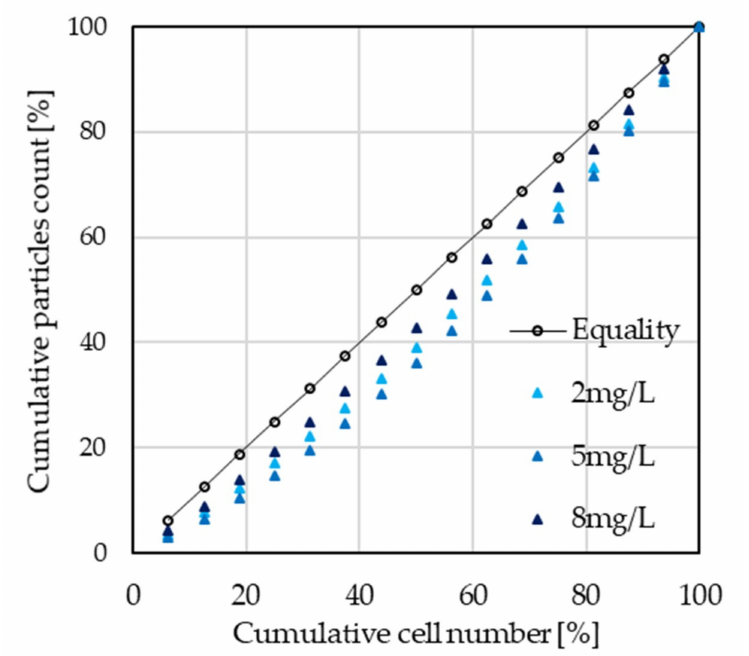
Figure 12. The Lorenz curve for the cumulative particle counts to cumulative cell numbers for SEM images. Feed water concentration—2, 5, and 8 mg /